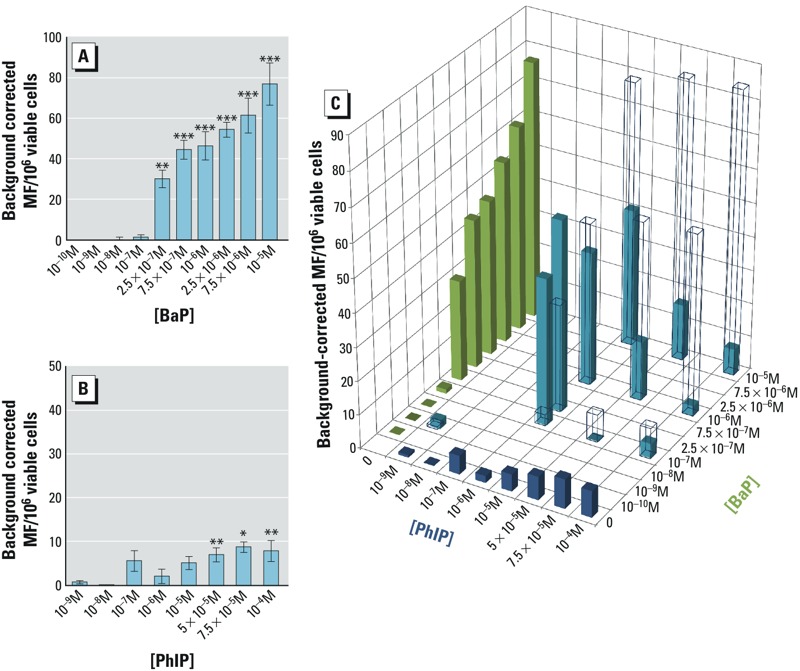
Effects of BaP, PhIP, or BaP/PhIP mixtures on mutant frequency (MF) at the TK locus. Background-corrected MF at the TK locus following a 24-hr treatment with (A) BaP, (B) PhIP, or (C) BaP/PhIP mixtures; in (C), open bars represent the predicted MF based on additivity, and solid bars represent the actual MF. The green bars represent the measured MF for PhIP alone, the blue bars represent the measured MF for BaP alone, and the teal bars represent the measured MF for PhIP/BaP mixtures. DMSO negative control average range, 4.9–18.6 MF/106 viable cells; EMS positive control average range, 74.6–125.5 MF/106 viable cells. Historical controls: TK: DMSO, 13.3 ± 9.4 MF/106 viable cells ± standard deviation; EMS (positive control), 99.4 ± 40.4 MF/106 viable cells ± standard deviation; Data are means ± SEM, n = 3–12 independent cultures.
Significance compared with DMSO control [one-way analysis of variance (ANOVA) with Dunnett’s post-test; *p ≤ 0.05, **p ≤ 0.01, ***p ≤ 0.001].